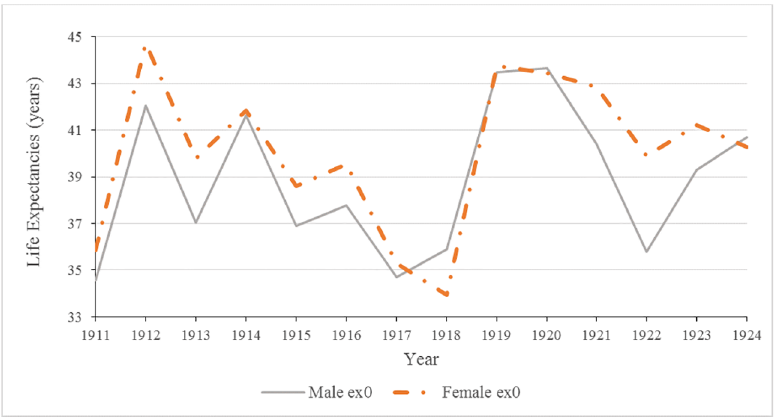
Fig 1. Male and female life expectancyat birth: Malta 1911 to